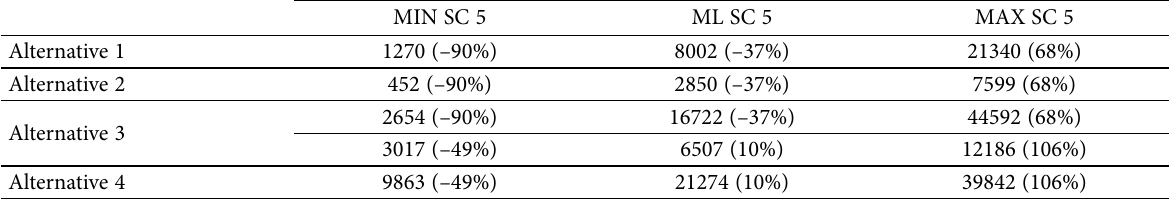
Table 9. Focal scenario 5 TTS-TR parameters to the PERT distribution [mDKK]